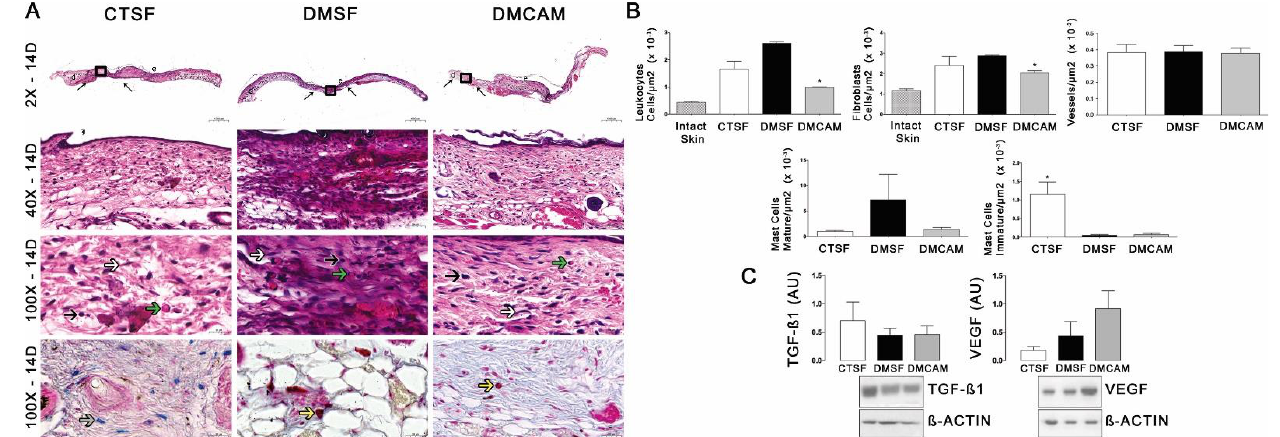
Figure 5. Topical treatment with plasticized chitosan-alginate membranes in diabetic mice reduced the number of inflammatory cells and fibroblasts in the wound bed. ( A ) photos representing skin stained with H&E on day 14 of the wound. Less enhanced black arrows indicate the location where the excisional wound was performed. Small letters represent: sc, scab; e, epidermis; g, granulation tissue; d, dermis; pc, panniculus carnosus. Boxes in the upper panels indicate areas where regions that were amplified are shown to illustrate leukocytes (black arrows), fibroblasts (white arrows), and new vessels (green arrows). ( B ) number of leukocytes, fibroblasts, vessels, and blood capillaries by µ m 2 × 10 − 3 ; at day 14, the DMCAM group showed significantly lower numbers of leukocytes and fibroblasts in comparison to the CTSF and DMSF groups; the CTSF group showed a significantly higher quantity of mastocytes than the DMSF and DMCAM groups. Histological staining with Alcian-Blue + Safranin on skin fragments on day 14 after creating the wound on backs of mice for analysis of mature mastocytes (yellow arrows) and immature mastocytes (grey arrows). ( C ) Analysis of the skin fragment (wound) with Western Blotting, with VEGF and TGF − β 1 and Beta Actin (Control), of animal groups CTSF, DMSF, and DMCAM, on post-wound day 14. * Groups statistically different ( p < 0.05), compared by One-way ANOVA, followed by a Tukey multiple comparison test. Enlargements of 1.5 × , 3 × , 40 × e 100 × ; scale bar = 1000 µ m, 500 µ m, 50 µ m and 20 µ